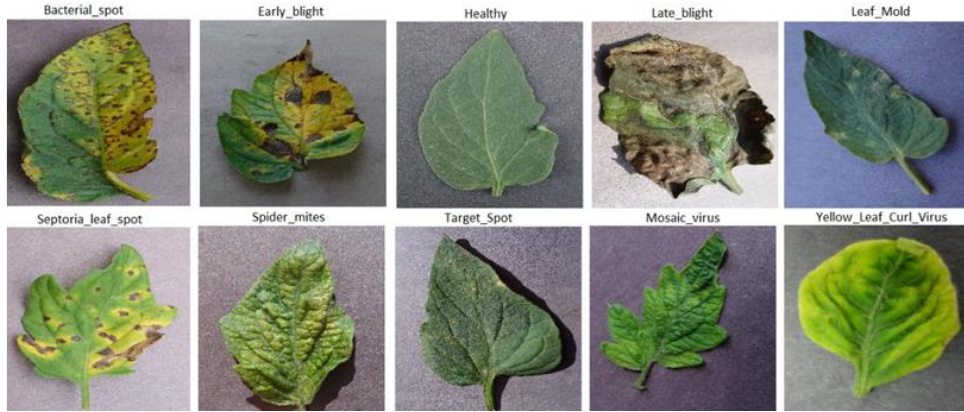
Figure 1. Examples of original PlantVillage dataset [10].